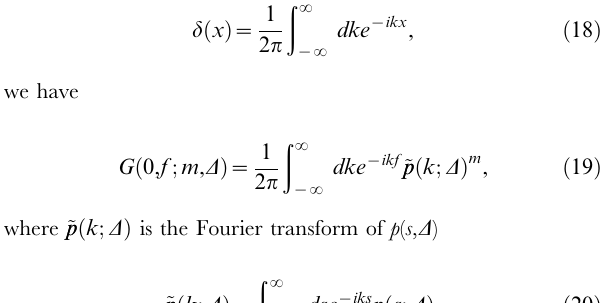
Figure S1. Orange randomization test for the lambda phage genome with a BCAI cutoff of c = 0.5. As expected, the only qualitative difference between this figure and Figure 5 in the paper is the scale on the y-axis. Figure S2 Lambda Phage BCAI landscapes for different cutoff values. Lamba phage BCAI landscapes for different cutoffs, c, where we have assigned codons with w $ c a value of BCAI = 0.7, and w , c a value of BCAI =0.3. Note that the landscapes are qualitatively the same and only differ in y-scale. As we expect, the smaller c, the more BCAI =0.7 codons, and thus the large the y- scale of the landscapes. Found at: doi:10.1371/journal.pcbi.1000001.s002 (0.75 MB